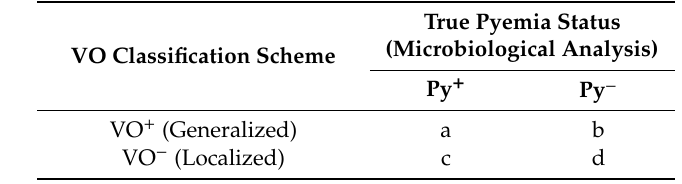
Table 1. Table used to calculate sensitivity, specificity, positive predictive values (PPV), and negative predictive values (NPV), based on VO (Vertebral osteomyelitis) classification scheme (VO) and on pyemia (Py)